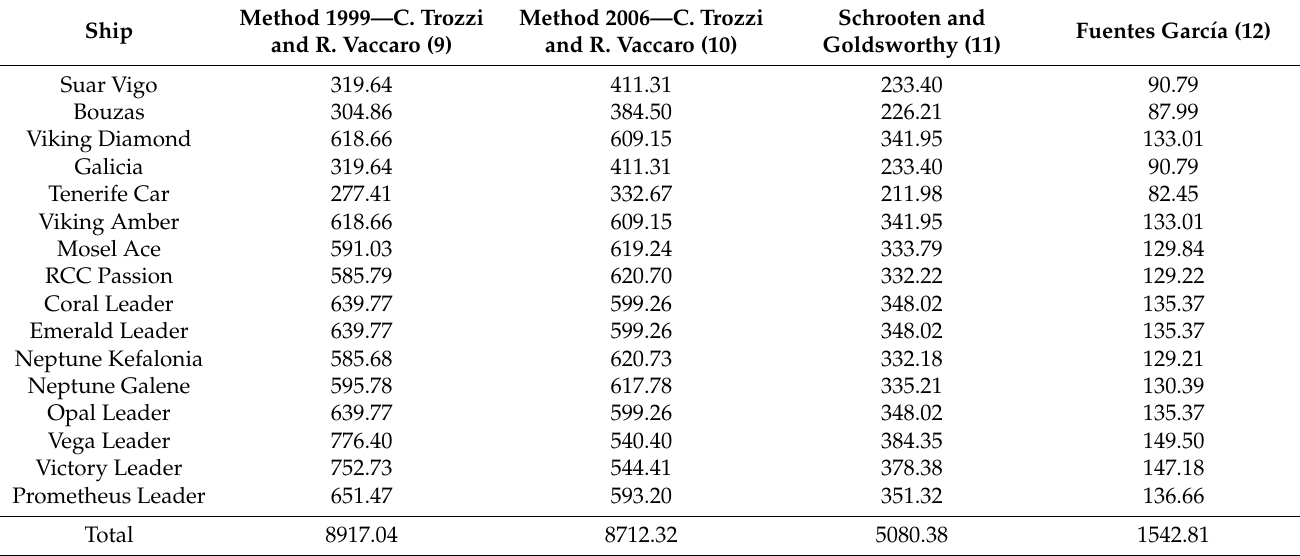
Table 11. Fuel consumption (kg/h) estimate comparison in